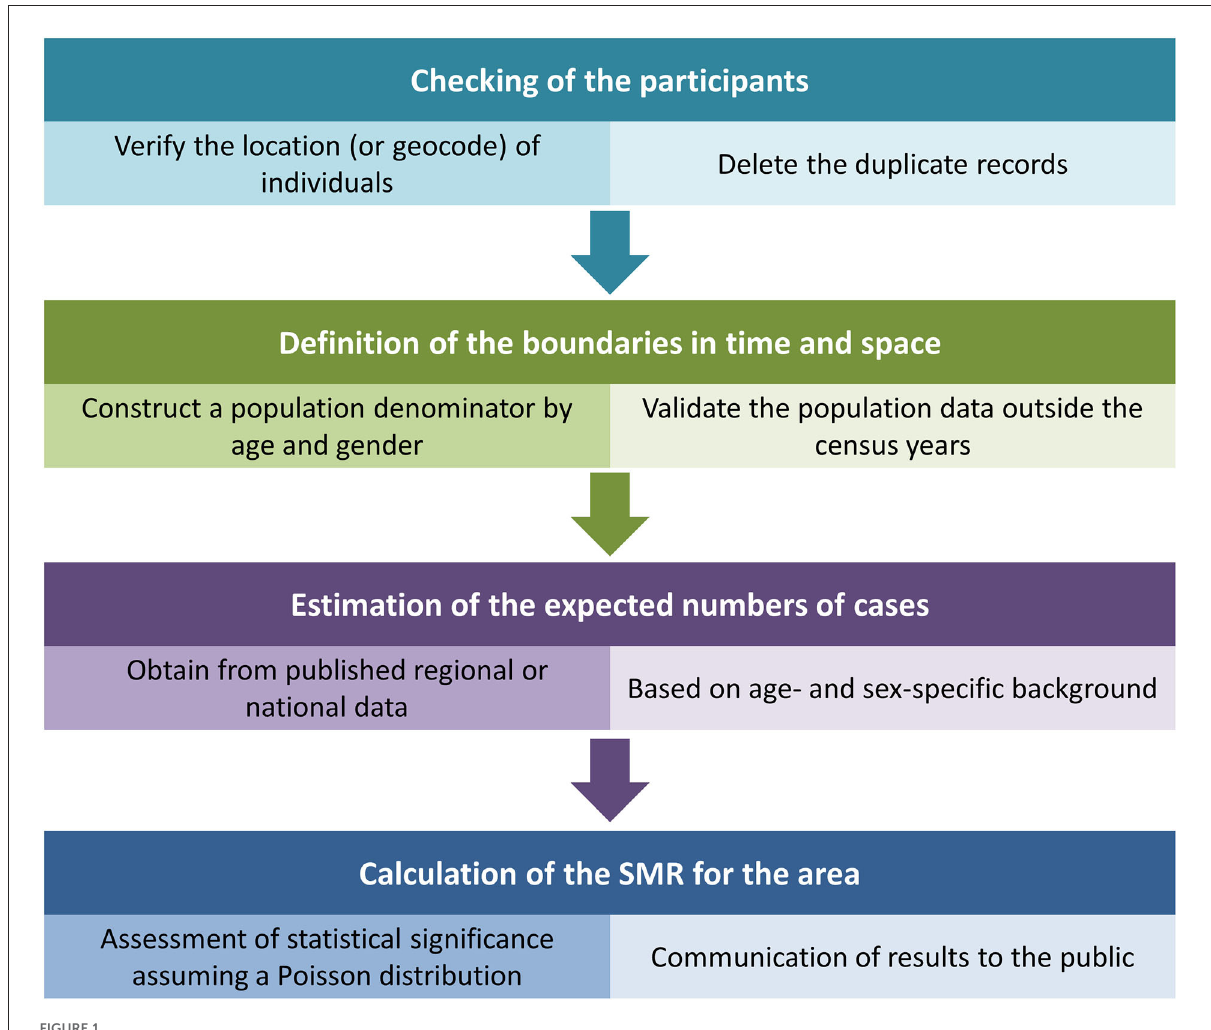
FIGURE1 The process of the initial assessment of the data in spatial